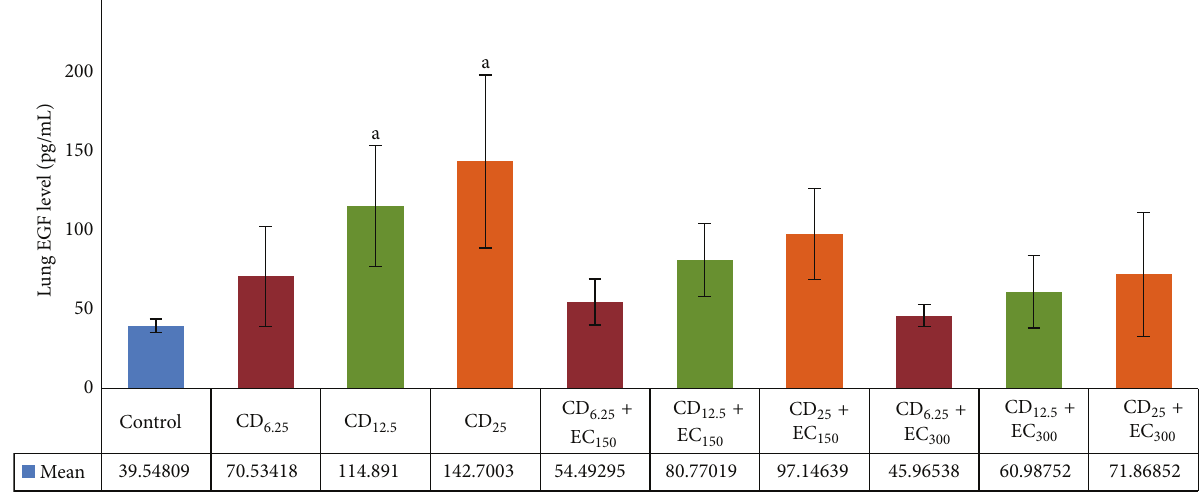
Figure 4: The levels of lung EGF. The lung EGF levels were increased in coal dust-exposed groups at doses of 12.5 and 25mg/m 3 than that in non-exposure group but decreased in the respective E. cottonii -supplemented groups. a 𝑃 < 0.05 in comparison with non-exposure group, b 𝑃 < 0.05 in comparison with its coal dust-exposed non-supplemented group. Non-exposure group (control); group exposed to coal dust at dose of 6.25 mg/m 3 (CD 6.25 ), 12.5mg/m 3 (CD 12.5 ), or 25 mg/m 3 (CD 25 ); group supplemented with the ethanolic extract of E. cottonii at dose of 150 (EC 150 ) or 300 mg/kgBW (EC 300 ).